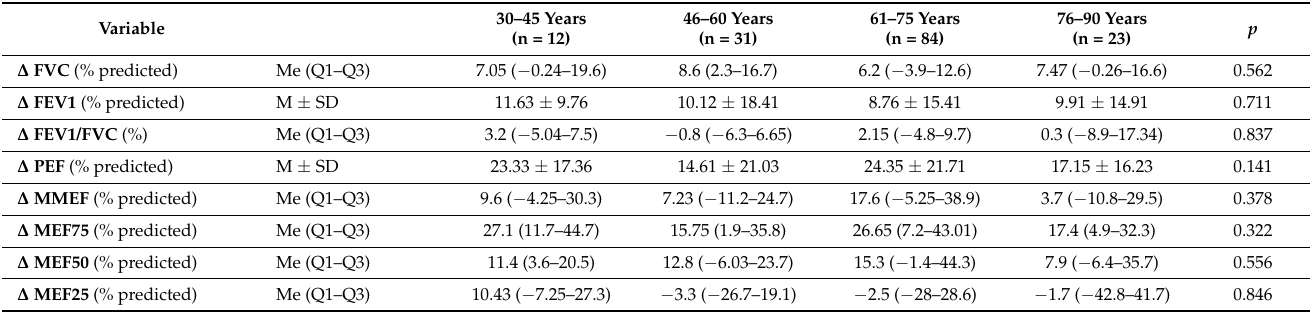
Table 8. Relationships between the difference in spirometric results before and after rehabilitation and